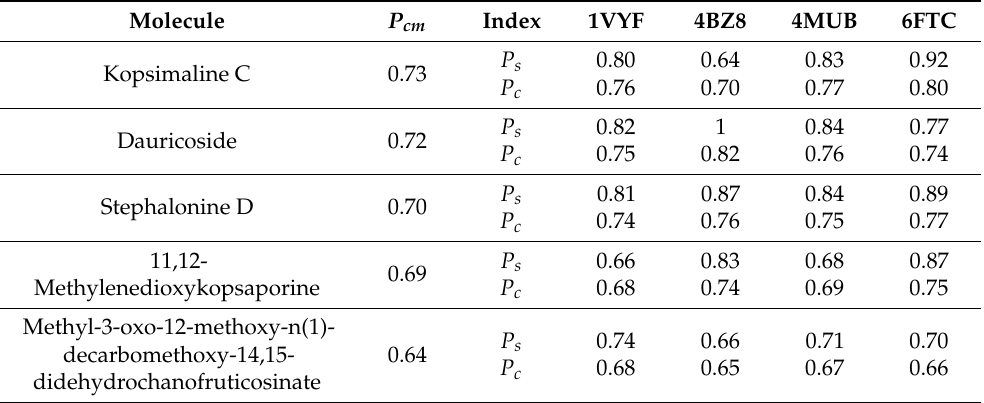
Table 4. Consensus hits of the five alkaloids from structure- and ligand-based virtual screening; P cm is the combined probability between the models in ligand-based VS, Ps is the probability value in the structure-based VS, and P c is the combined approach